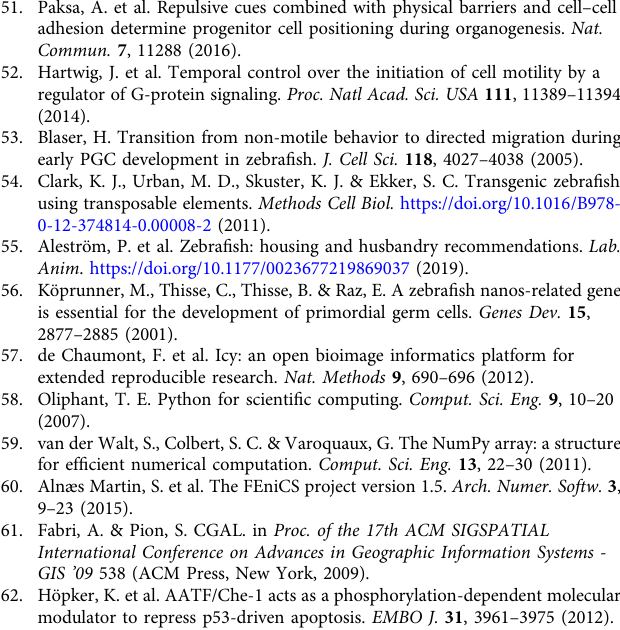
Fig. 4c and Supplementary Fig. 9; C.G. performed all the other experiments and analyzed the data. C.G. and E.R. designed the experiments and wrote the manuscript. All authors read and approved the